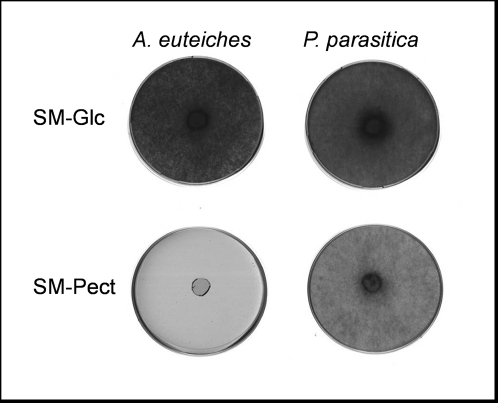
Growth of A. euteiches on synthetic media.
A. euteiches and Phytophthora parasitica mycelium were grown on synthetic medium containing Glucose (SM-Glc) or Pectin (SM-Pect) as carbon source. Photos were taken 15 days after inoculation.